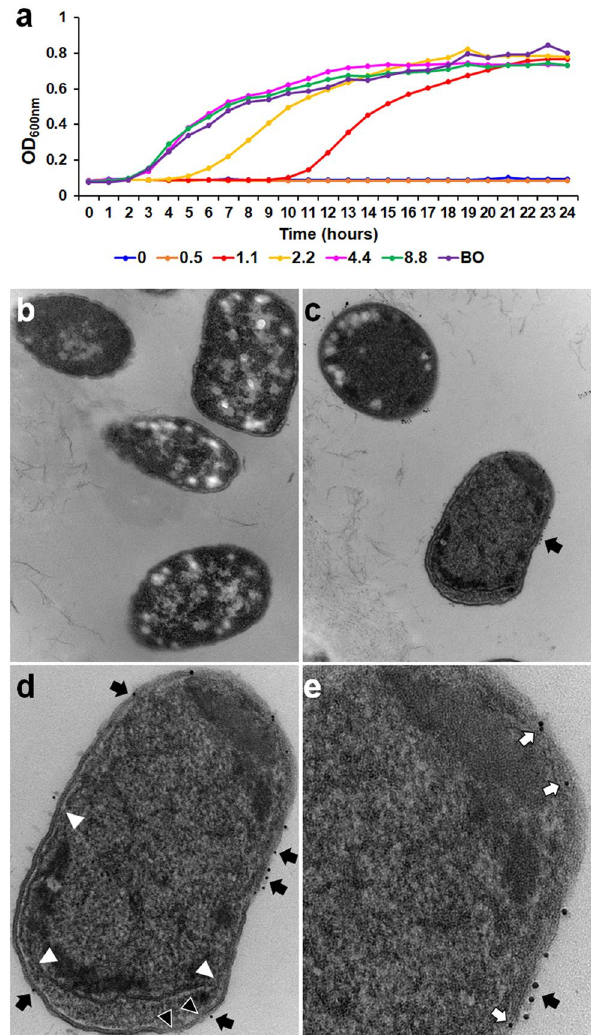
Figure 6. NK2A binding to Salmonella lipopolysaccharides (LPS). ( a ) Affinity of NK2A to Salmonella LPS was assessed by bacterial growth assay. Five µM (or 2.2 μg) NK2A was preincubated with different concentrations of Salmonella LPS (0.5–8.8 μg) for 30 min prior to incubation with MDR Salmonella outbreak isolate SX238, and growth was recorded for 24 h using an automated growth curve reader (OD 600nm ; BO = bacteria only). One representative graph out of three independent experiments is shown. ( b – e ) TEM images were obtained for Salmonella outbreak isolate SX238 incubated with control AuNPs ( b ) or 20 μM NK2A-AuNPs ( c – e ). Black arrows indicate NK2A-AuNPs bound to MDR Salmonella LPS (outer membrane) and white arrows indicate NK2A-AuNPs bound to the inner cytoplasmic membrane. White triangles indicate damaged inner cytoplasmic membranes and black triangles indicate damaged outer membranes (LPS; d ). A larger periplasmic space was observed in the bacteria incubated with NK2A-AuNPs compared to control AuNPs. (b/c = 30,000 × magnification; d = 68,000 × magnification; e = 120,000 × magnification). Representative images out of two independent experiments are